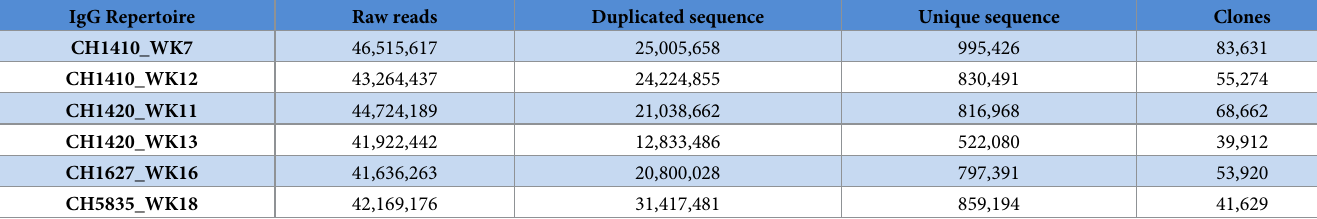
Table 2. Sequence